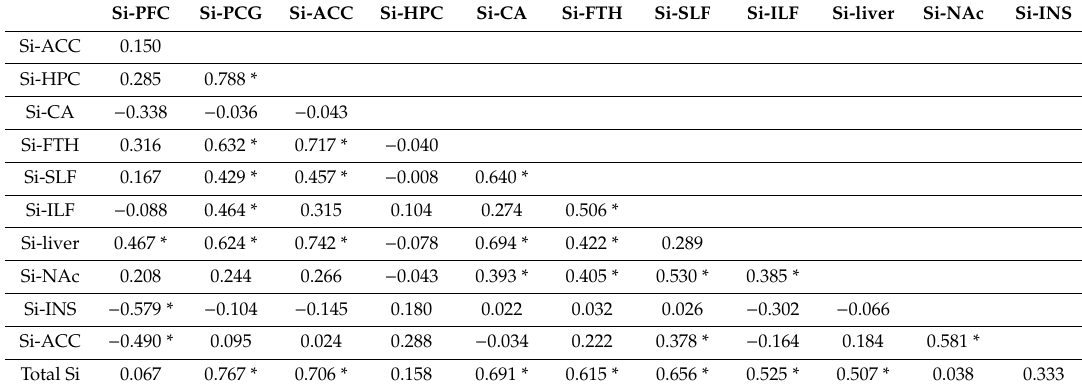
Table 5. Spearman correlation coe ffi cient for Si content in various brain structures of AUD subjects and in their liver. Asterisks indicate p < 0.05.